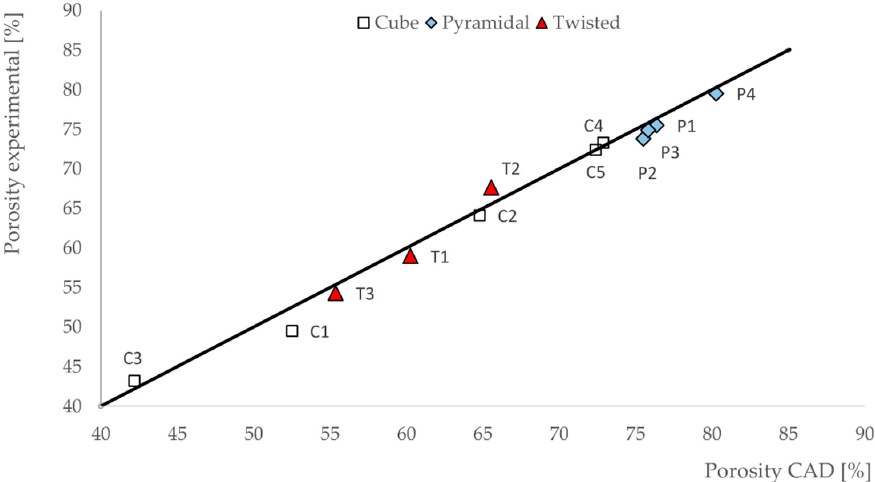
Figure 3. Porosity of the three investigated designs, i.e., cubic, pyramidal and twisted, and all of their configurations. The results for CAD porosity are shown in comparison to the experimentally determined porosity.